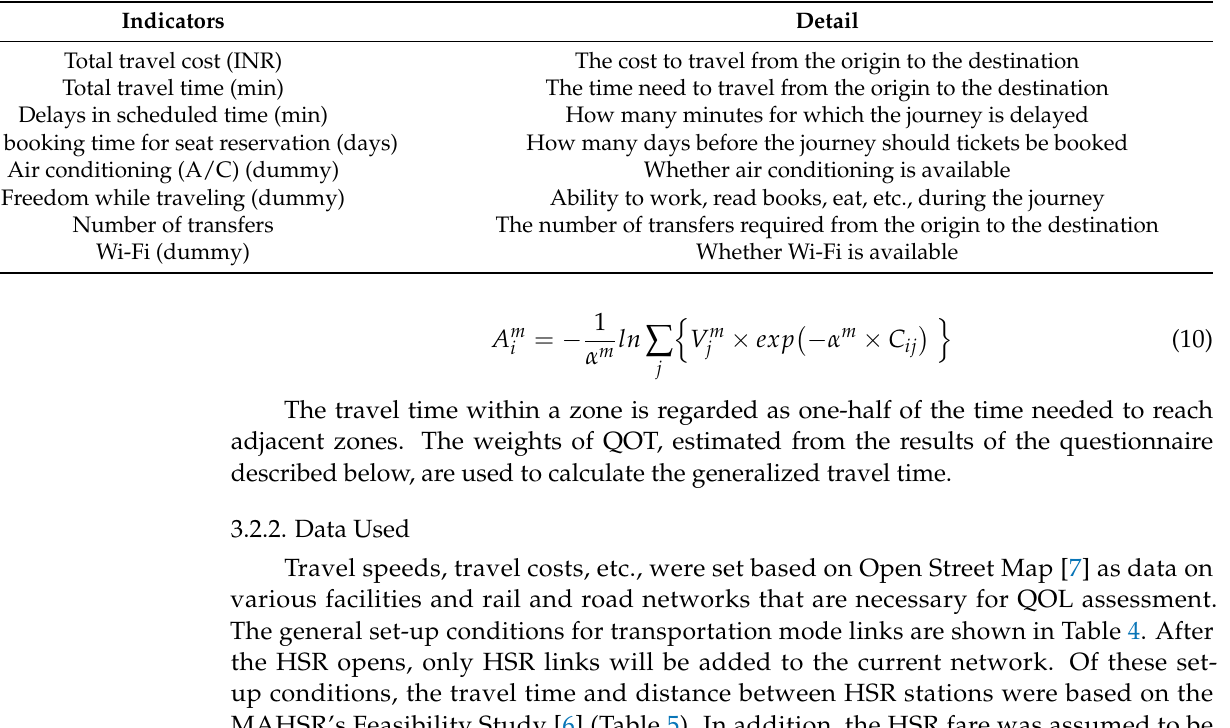
Table 3. Quality of travel (QOT)